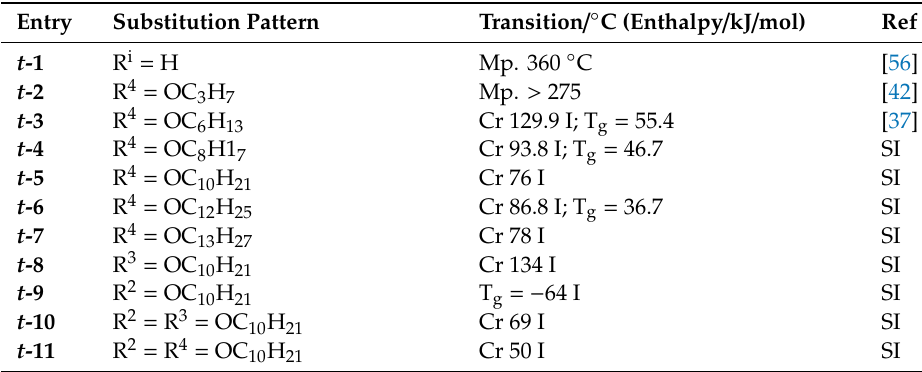
Table 1. Mono-, di- and tri-1- n -alkoxy t -TTTs and their thermal characteristics.